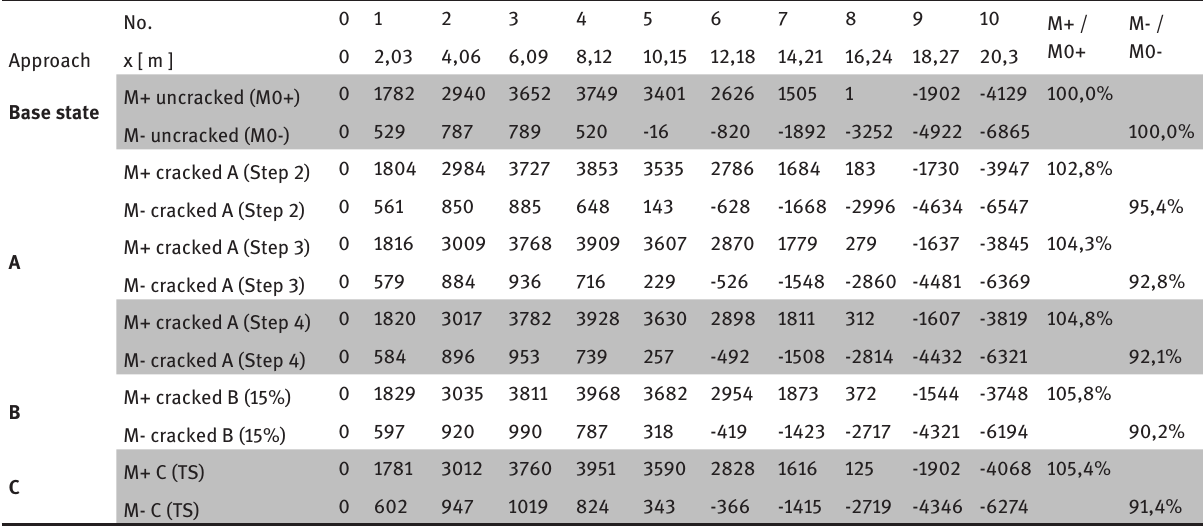
Table 1: Bending moment values (kN m) along the girder’s length (m), depending on the assumed approach (A, B, C). Numerical interpretation of Fig. 19.